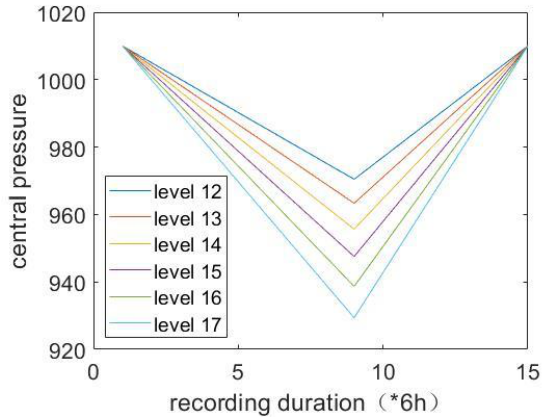
Figure 4. Time – history curve of the central pressure (hPa) distribution of typhoons of different levels.